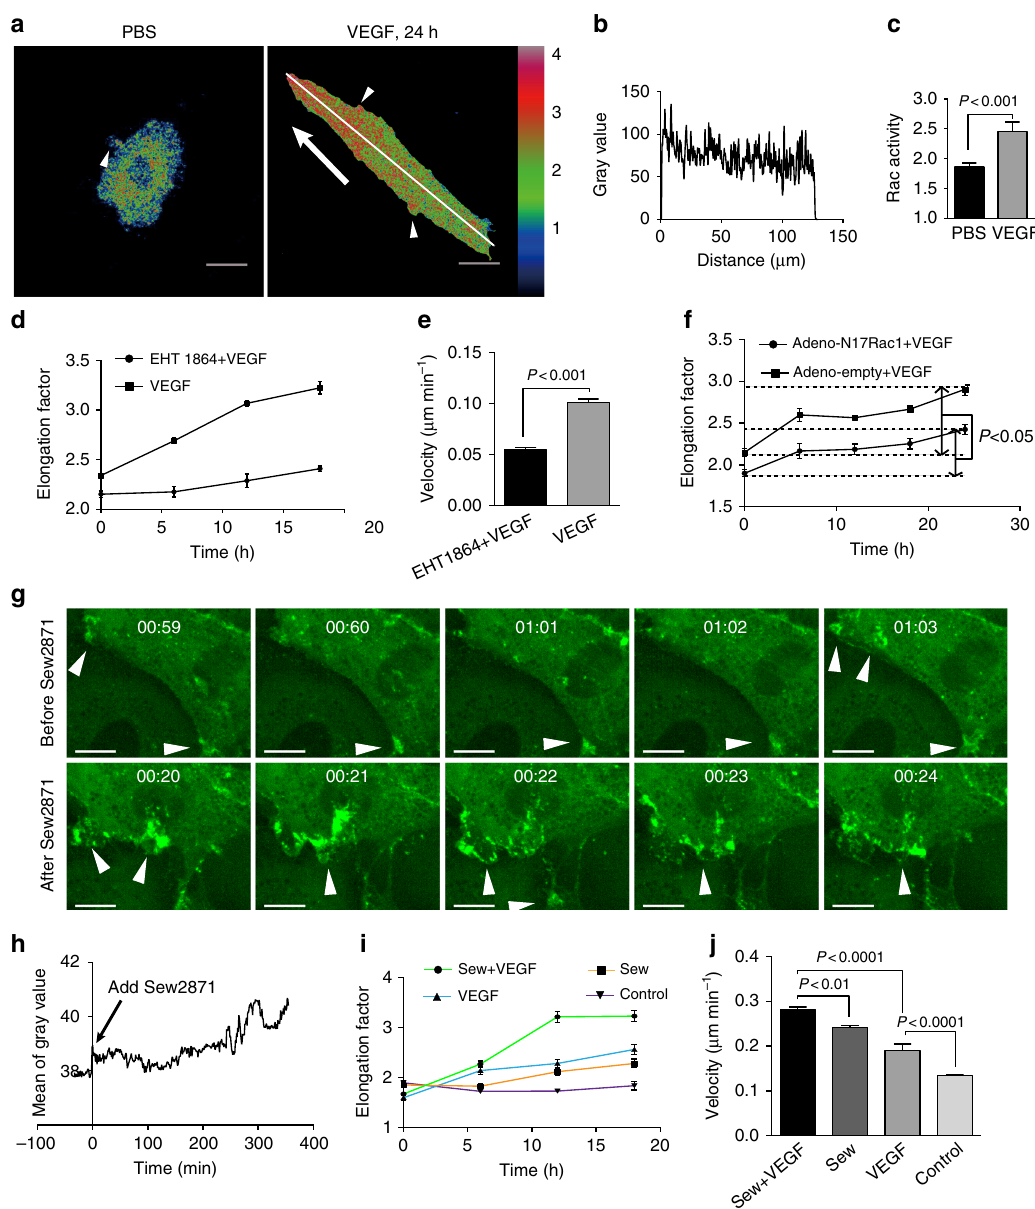
Fig. 8 Polarized Rac activity is required for VEGF-induced cell elongation and migration. a – c Con fl uent HUVECs expressing FRET sensor Raichu-Rac1 were treated with VEGF for 24 h. a Representative images showing different levels of Rac1 activity within control cells and VEGF-induced elongated cells. Control cells displayed less and randomised Rac1 activity (arrowhead; compare Supplementary Movie 13). Polarized, higher Rac1 activity is observed at the leading front (arrow indicates migration direction; compare Supplementary Movie 13). Small foci of elevated Rac activities are observed at the lateral side (arrowheads); scale bars: 20 µ m. b Plot of fl uorescence intensity along the line is indicated. c Quanti fi cation of overall Rac1 activity as de fi ned by the ratio of YFP/CFP in PBS- or VEGF-treated cells ( n = 74 and 87 cells were analysed from 4 independent experiments for PBS and VEGF, respectively (unpaired student ’ s t test)). d , e Con fl uent HUVECs pre-treated with EHT1864 for 30 min were treated with VEGF for additional 19 h. Quanti fi cation of ( d ) elongation factor and ( e ) migration velocity after EHT1864 + VEGF ( n = 100 cells) and VEGF ( n = 101 cells) treatment for the time period of 19 h (unpaired student ’ s t